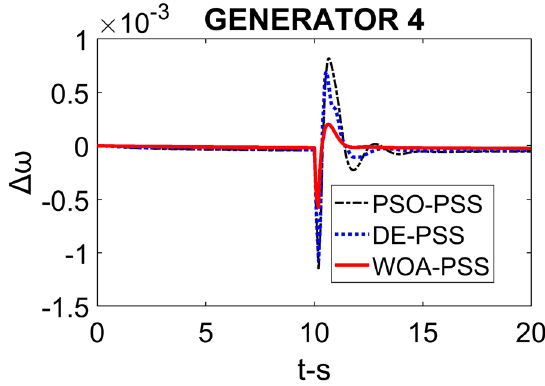
Fig. 14 speed deviation of G2 under 3- φ fault at t = 10 s Fig. 16 speed deviation of G4 under 3- φ fault at t = 10 s